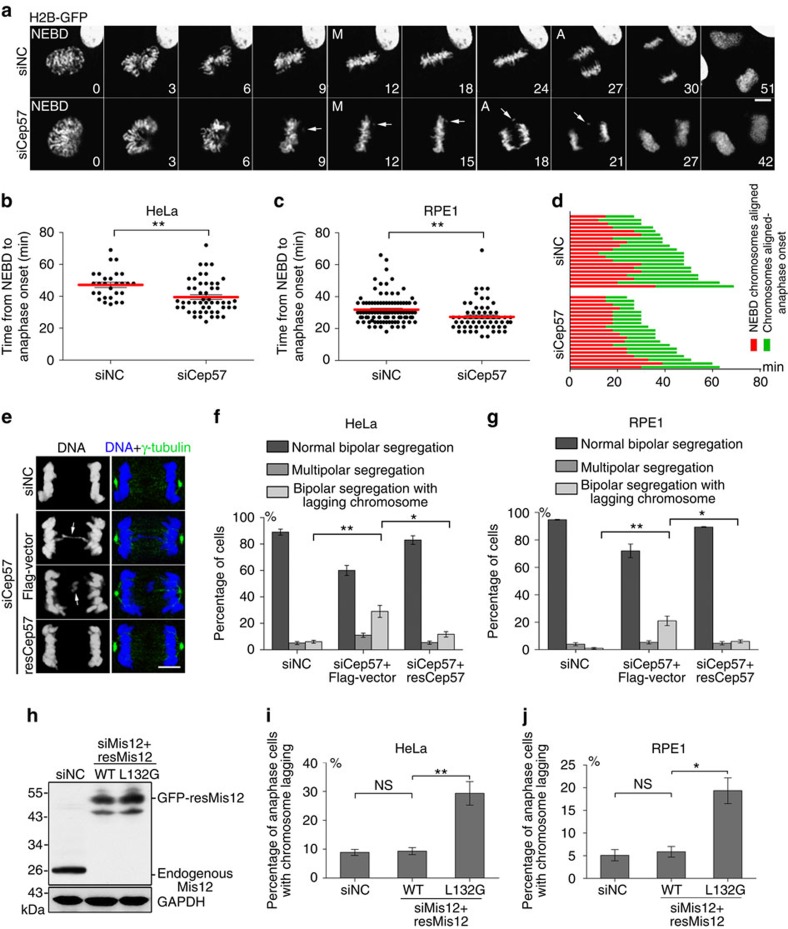
Cep57 depletion accelerates anaphase onset and leads to chromosome lagging.(a) Time-lapse images of RPE1 cells co-transfected with H2B-GFP and negative control (NC)- or Cep57-siRNA for 60 h. NEBD, nuclear envelope breakdown; M, metaphase; A, anaphase. The numbers indicate the time (minutes) after NEBD. Arrows, misaligned chromosomes and lagging chromosomes. Scale bar, 5 μm. (b,c) Quantification of time from NEBD to anaphase onset of HeLa (b) and RPE1 cells (c) co-transfected with H2B-GFP and NC- or Cep57-siRNA for 60 h. Scatter plots show data from three independent experiments (red lines indicate the average). Data are mean±s.e.m. **P<0.01 (unpaired two-tailed Student's t-test). (d) Mitotic progression from NEBD to anaphase onset in HeLa cells transfected with H2B-RFP and NC- or Cep57-siRNA for 60 h. The cells were selected at random. (e) Immunostaining of γ-tubulin (green) in HeLa cells with NC-siRNA, Cep57-siRNA or Cep57-siRNA and siRNA-resistant Cep57 (resCep57) for 60 h. DNA was stained with 4,6-diamidino-2-phenylindole (DAPI, blue). Scale bar, 5 μm. Arrows, lagging chromosomes. (f,g) Percentages of anaphase HeLa (f) and RPE1 cells (g) after transfection with NC-siRNA, Cep57-siRNA or Cep57-siRNA and siRNA-resistant Cep57 (resCep57) for 60 h. The experiments were repeated three times. Data are mean±s.e.m. **P<0.01; *P<0.05 (unpaired two-tailed Student's t-test); n>200 cells per experiment. (h) Western blots show endogenous Mis12 depletion in HeLa cells after twice transfection of siRNA for 48 h, and rescue by expressing siRNA-resistant GFP-tagged wild-type (WT) or mutant L132G Mis12 (resMis12). (i,j) Percentages of anaphase HeLa (i) and RPE1 cells (j) after twice transfection of Mis12 siRNA and rescue by expressing siRNA-resistant GFP-tagged wild-type (WT) or mutant L132G Mis12 (resMis12). The experiments were repeated three times. Data are mean±s.e.m. **P<0.01; *P<0.05; NS, not significant (unpaired two-tailed Student's t-test); n>200 cells per experiment.